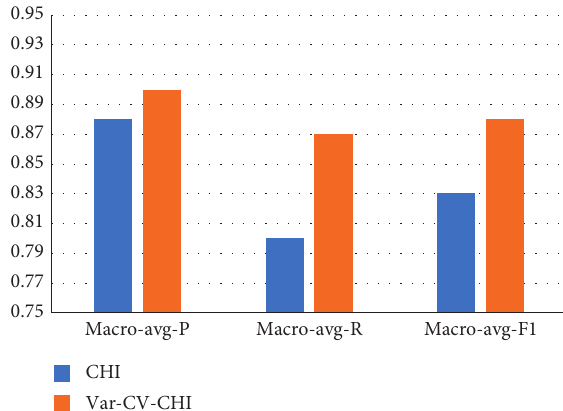
Figure 7: Comparison of macroresults between CHI and Var-CV- CHI on the unbalanced English corpus (KNN).